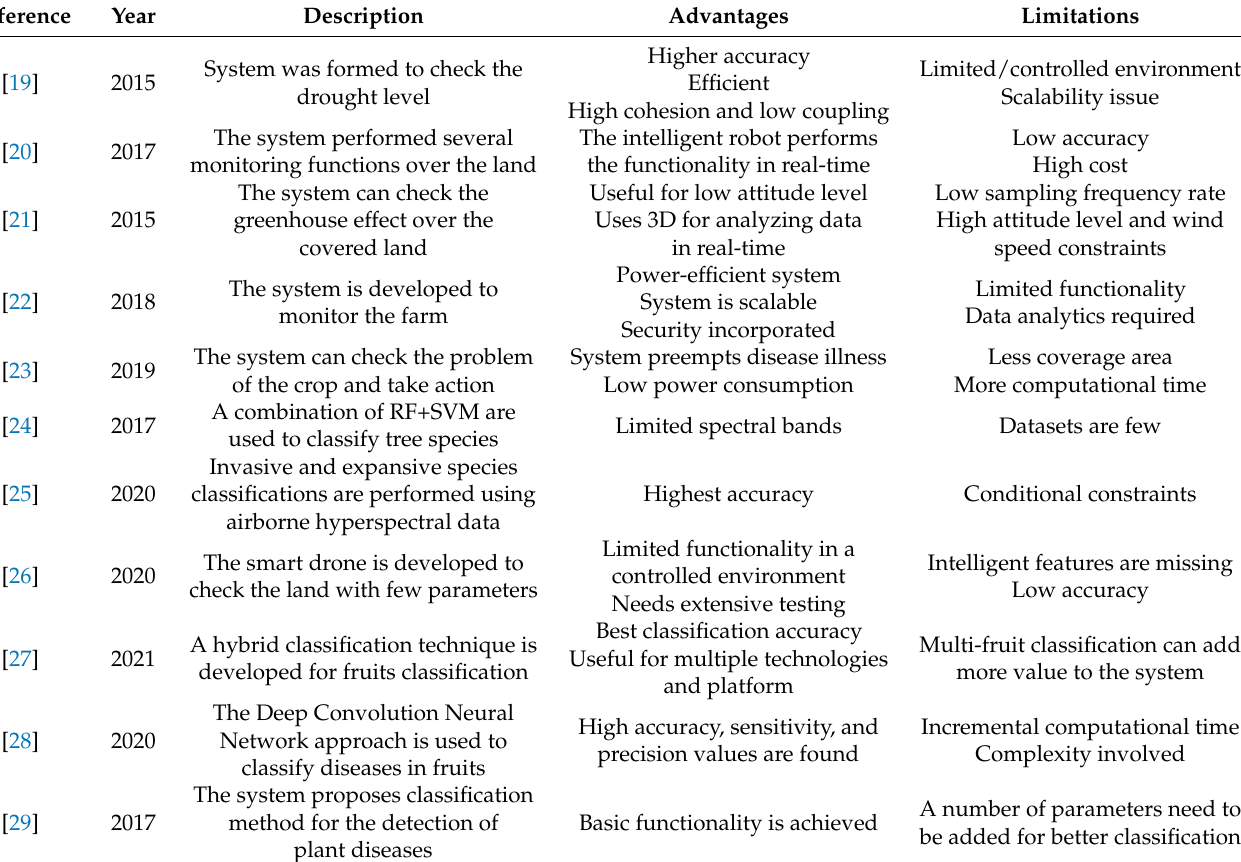
Table 1. Survey of various agriculture and classification-based